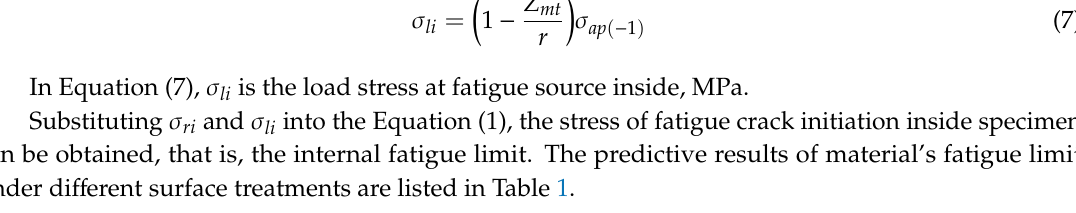
Figure 7. Tensile residual stress field of surface strengthened specimen after cycle stress. Load stress at fatigue source was calculated by Equation (7).